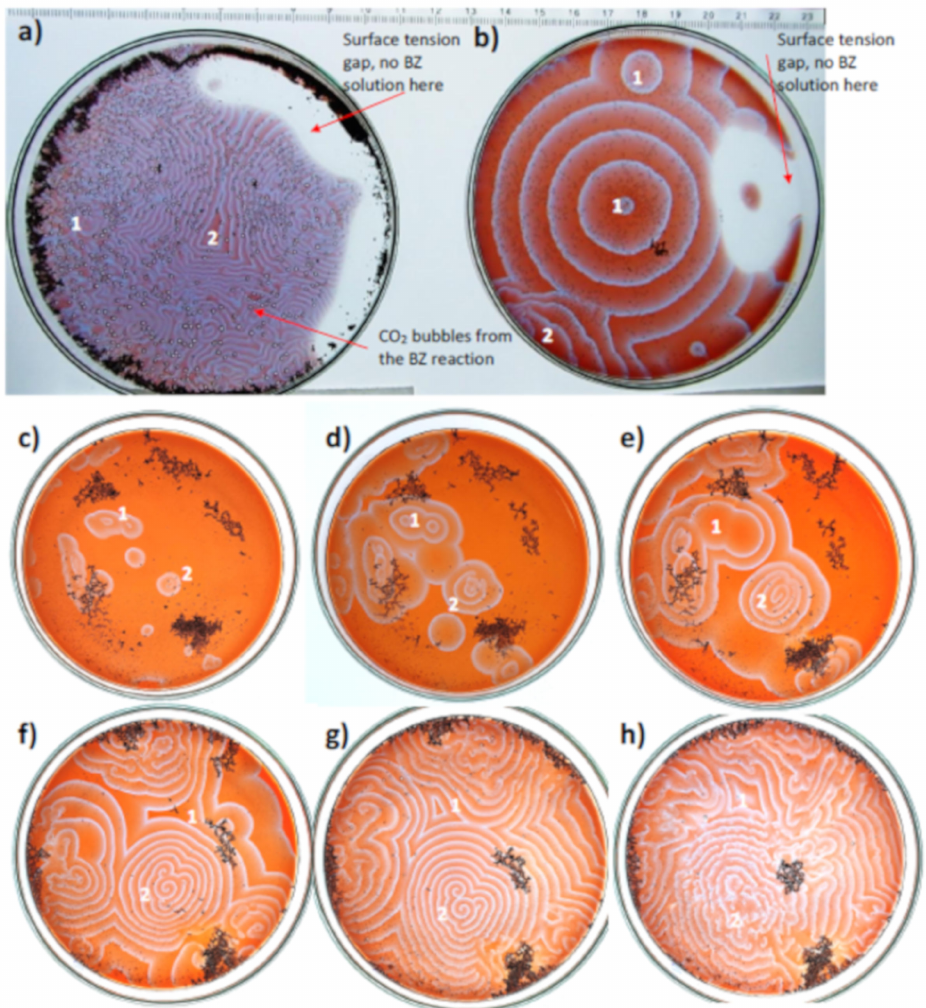
Figure 3. ( a ) and ( b ) Standard BZ reaction solution with the addition of humic acid particles (black) in the Petri dish prepared simultaneously. One full spatula of humic acid was initially placed on the dish with the BZ solution poured after. The motion and surface tension of the solution displaced the particles to the edge. This photo was taken after more than 15 min into the reaction and featuring zones of chaotic spiral patterns (1), a large number of CO2 bubbles throughout (small white disks with thin black rims), and a closed cavity (2). b) Same experiment with a small amount of particles placed in the centre of the dish with the mixed BZ solution being poured after the addition of humic acid. The experiment was mainly one central oxidation spots with lower frequency waves than Petri dish “a)” along with smaller carbon dioxide gas bubbles despite the almost simultaneous start time of the